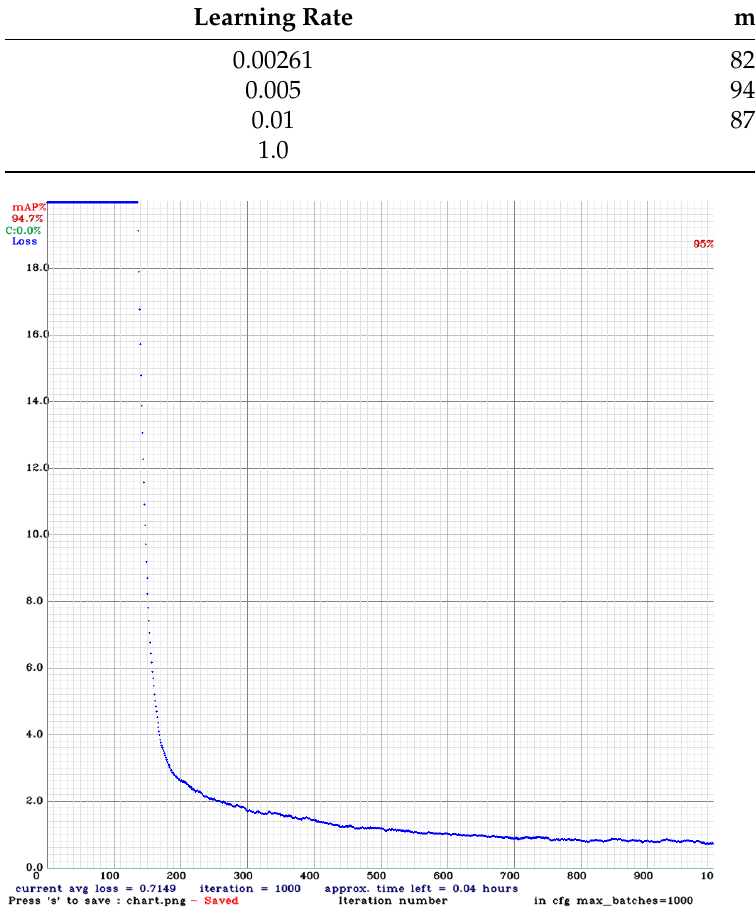
Figure 7. Training